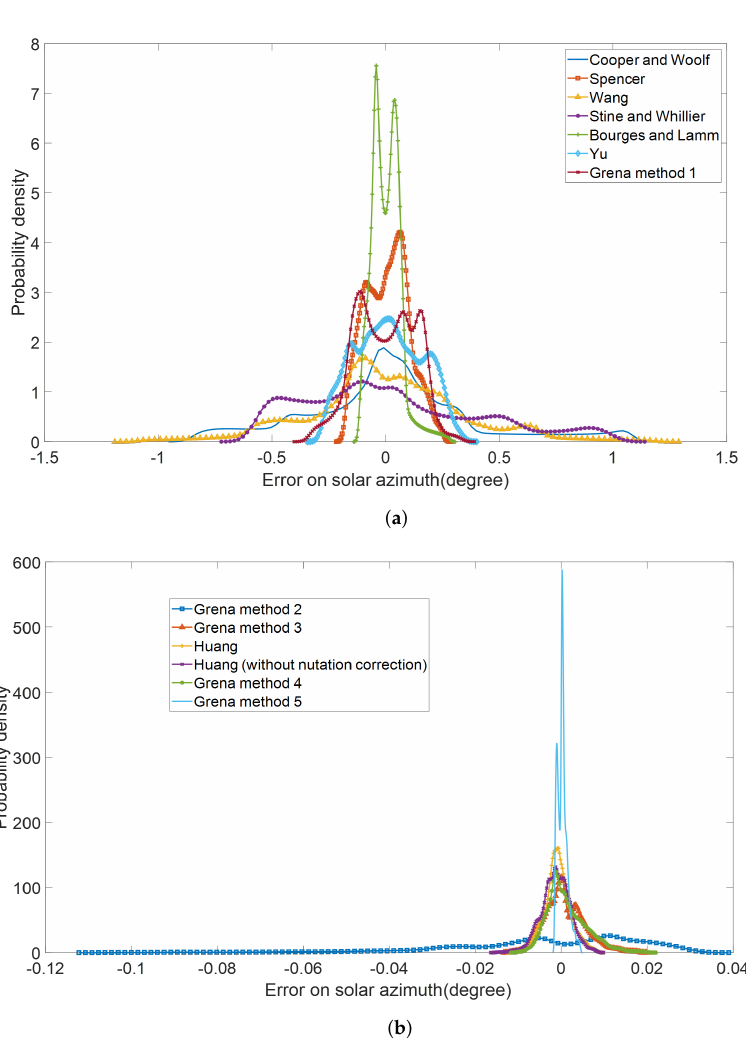
Figure 3. The probability density distribution of the calculation error of solar azimuth. ( a ) Solar position empirical algorithm. ( b ) Solar position complex algorithm.